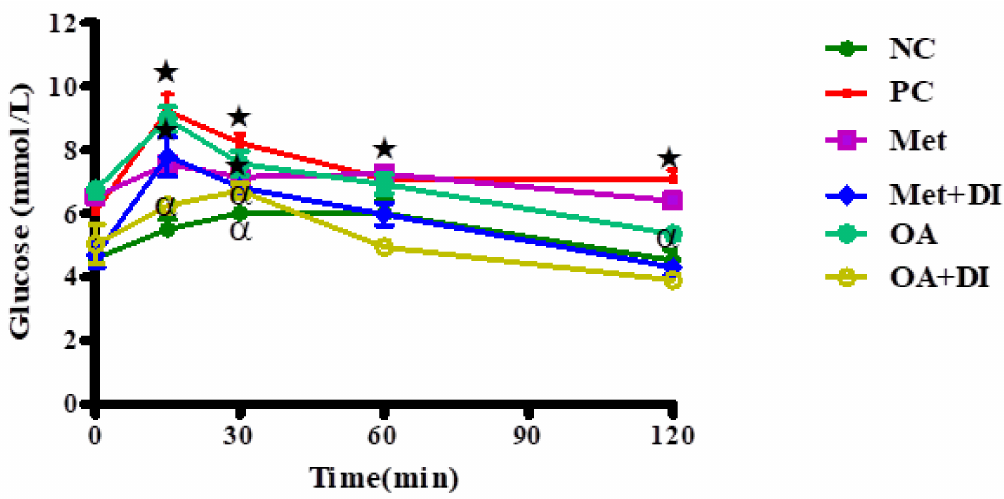
Figure 2. Effects of OA on OGTT of rats that were treated OA with and without diet intervention during treatment period. Values are presented as standard error of mean ± SEM. (cid:70) = p < 0.05 denotes comparison with NC; α = p < 0.05 denotes comparison with